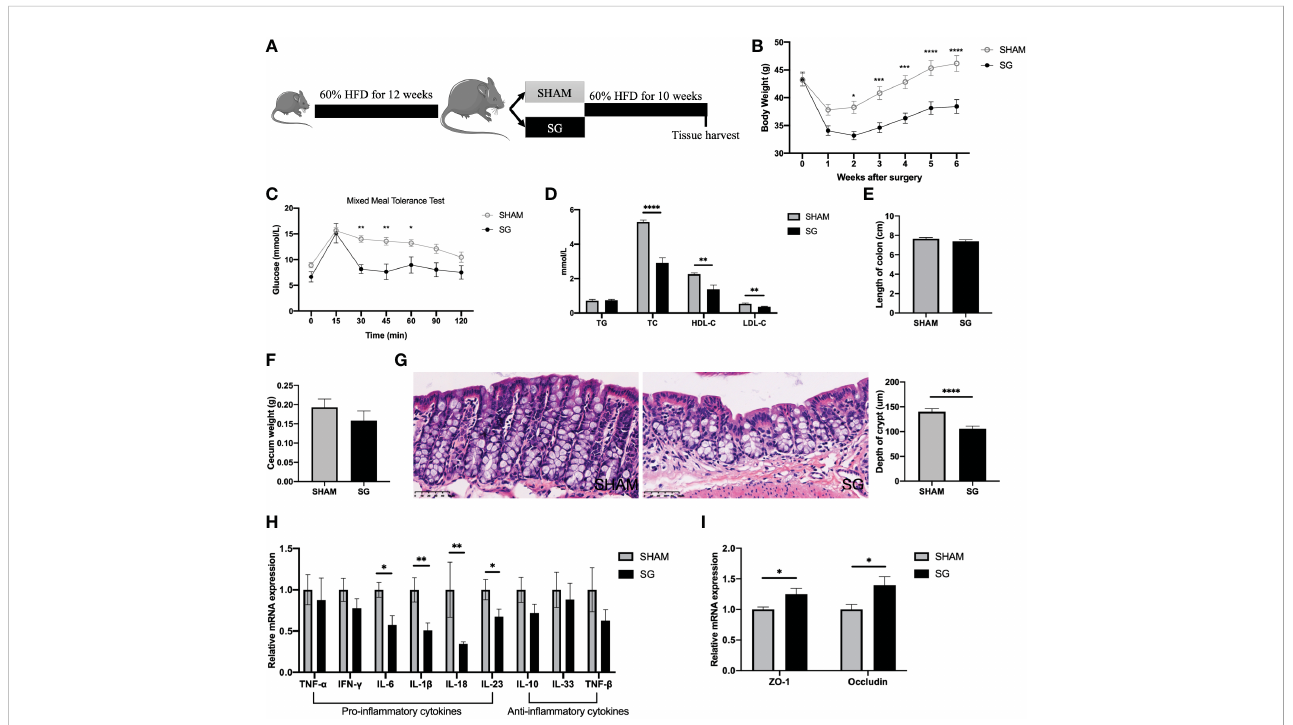
FIGURE 1 SG led to improvements in the HFD-feeding induced colonic pro-in fl ammatory status. (A) Experimental design and timeline (SG n=7; SHAM n=9). (B) Body weight. (C) Mixed meal tolerance test (MMTT). (D) Serum lipids. (E) Length of colon. (F) Cecum weight. (G) Representative H&E-staining images of colon (400x; scale bar, 50 um) and quanti fi cation of depth of crypt. (H) Gene expressions of in fl ammatory cytokines in the colon. (I) Gene expressions of tight junction proteins in the colon. n = 7 – 9/group; Data are presented as means ± SEM. Two-way ANOVA with post hoc Sidak test for multiple comparisons (B, C) and Student ’ s t-test (D, I) were used for signi fi cance assessments. ****P < 0.0001, ***P < 0.001, **P < 0.01, *P < 0.05. SHAM, sham surgery; SG, sleeve